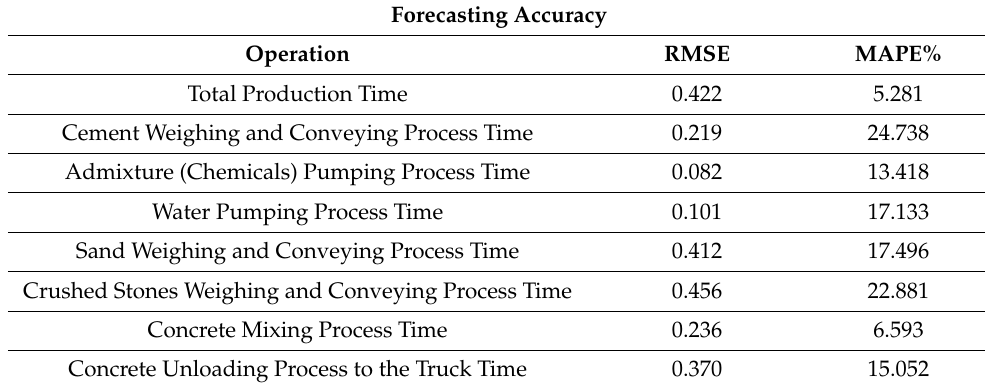
Table 8. Accuracy evaluation for production process forecasting models for disruption